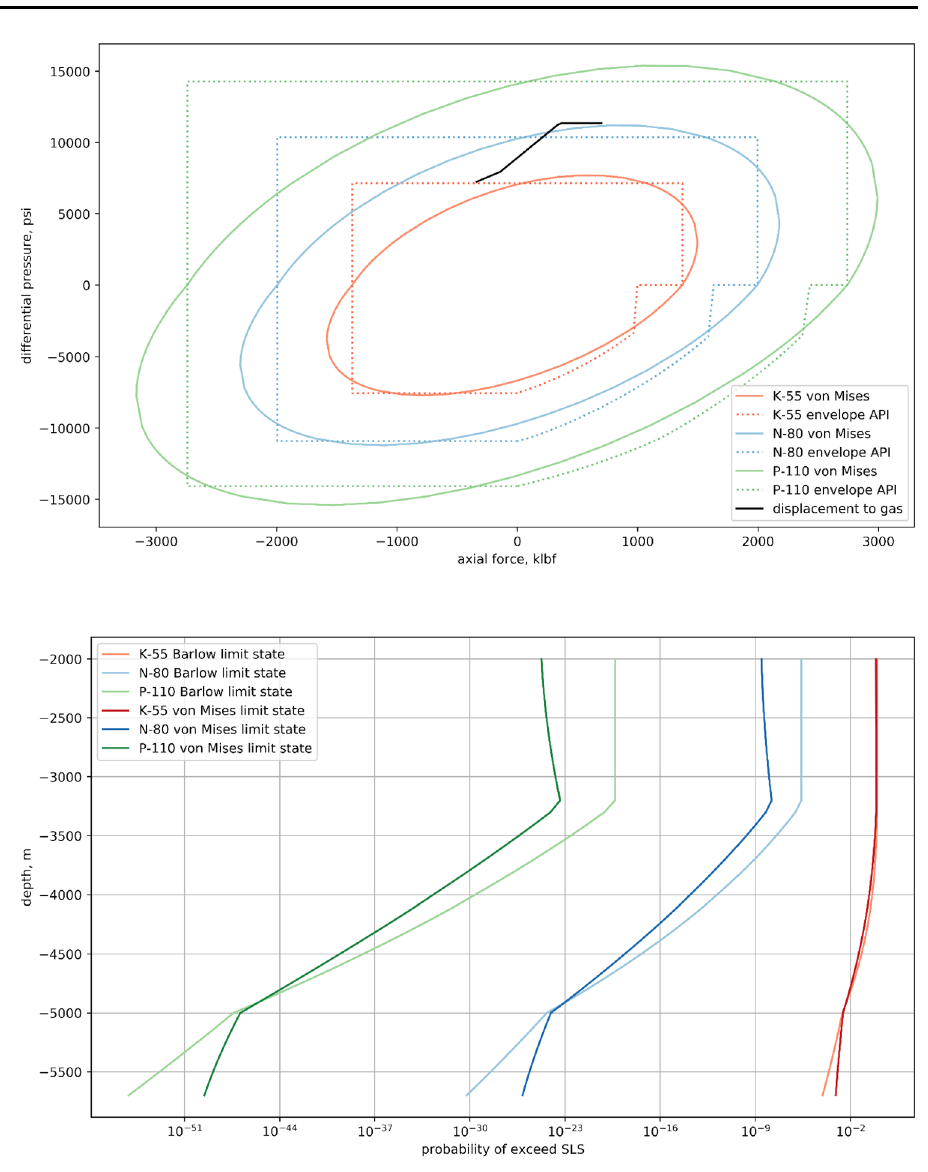
Fig. 13 von Mises and API envelopes for K55, N80 and P110 grades with D = 10.75” and t = 0.797”. The loads for displacement to gas scenario are also displayed